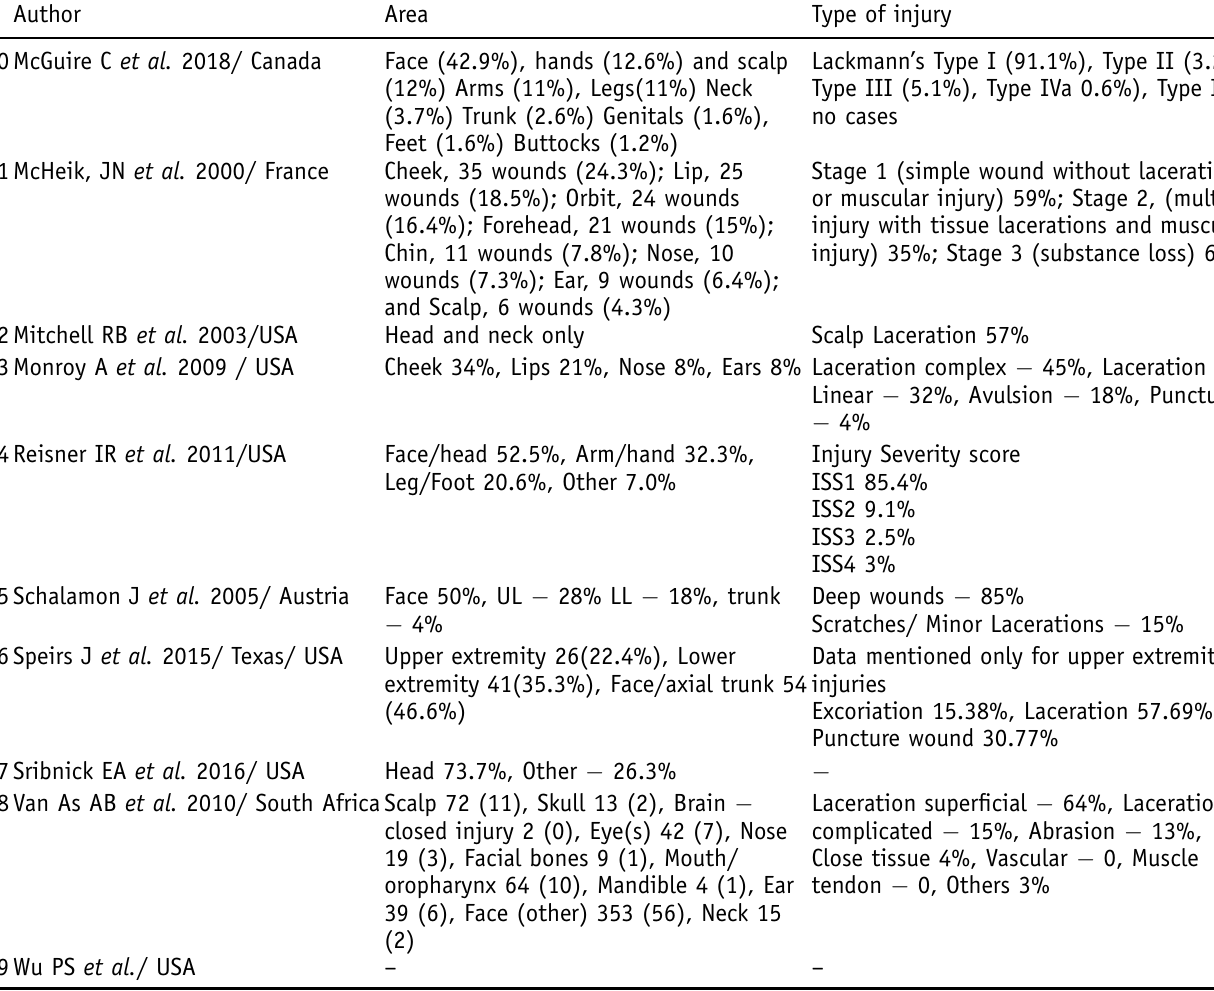
Laceration super fi cial (cid:3) 64%, Laceration complicated (cid:3) 15%, Abrasion (cid:3) 13%, Close tissue 4%, Vascular (cid:3) 0,